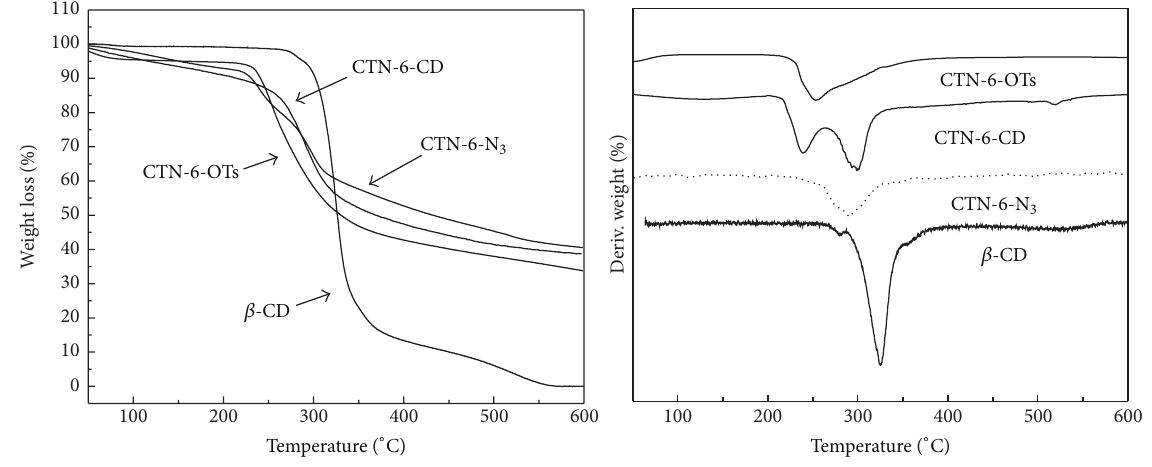
Figure 4: The TG and DTG curves of the synthesized products in the